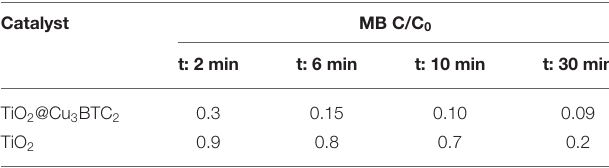
TABLE 7 | Photodegradation of phenol with various catalysts.